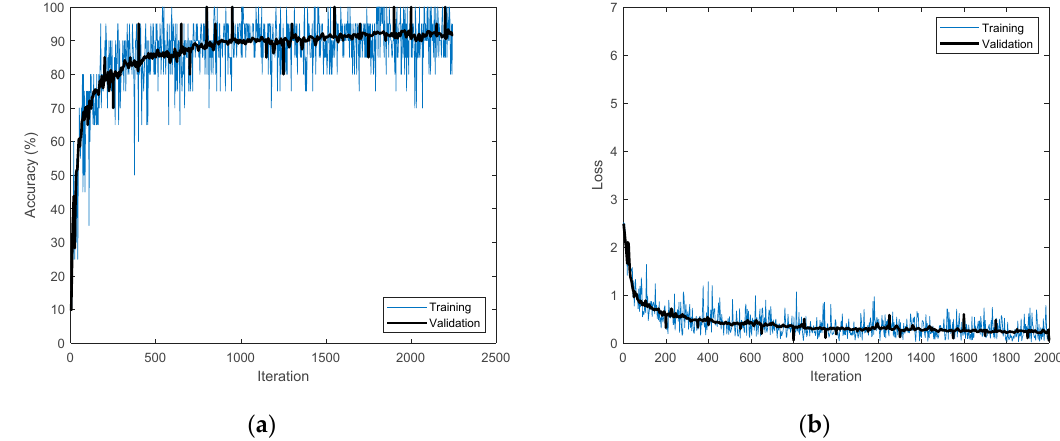
Figure 19. Training process for InceptionResNetV2 with preprocessing of type 2: ( a ) accuracy; ( b ) loss.